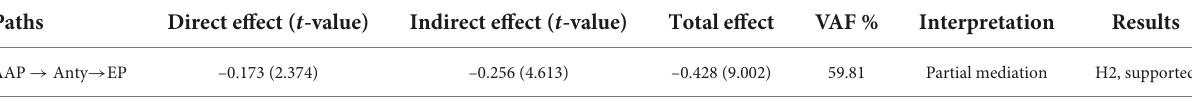
FIGURE2 Post analyses model.